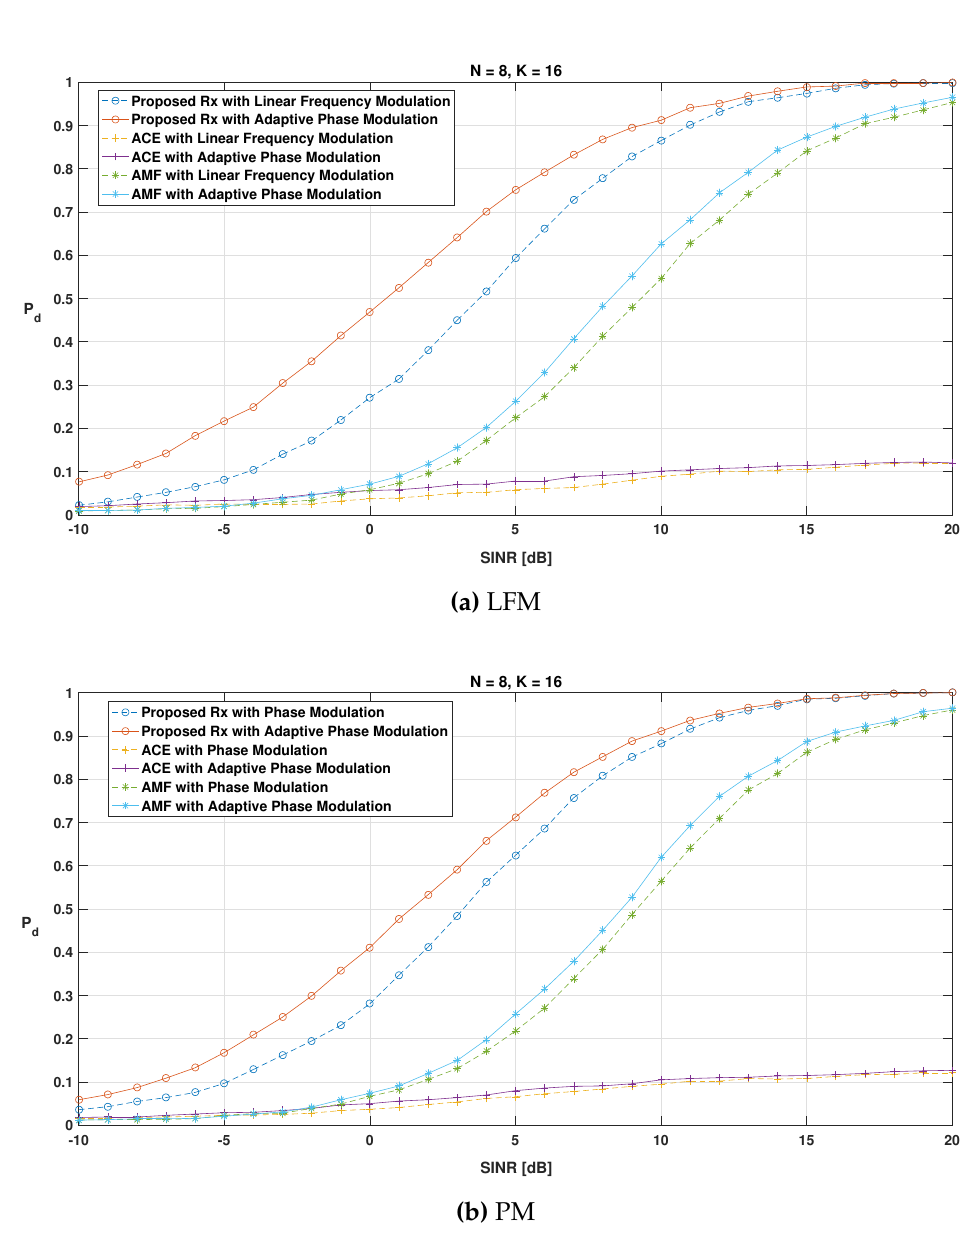
Figure 4. P d versus SINR curves at the end of Sub-dwell 1 (LFM) and using adaptive phase modulated waveform design in Sub-dwell 2 (APM); N = 8, K = 16, P fa = 10 − 2 , L =